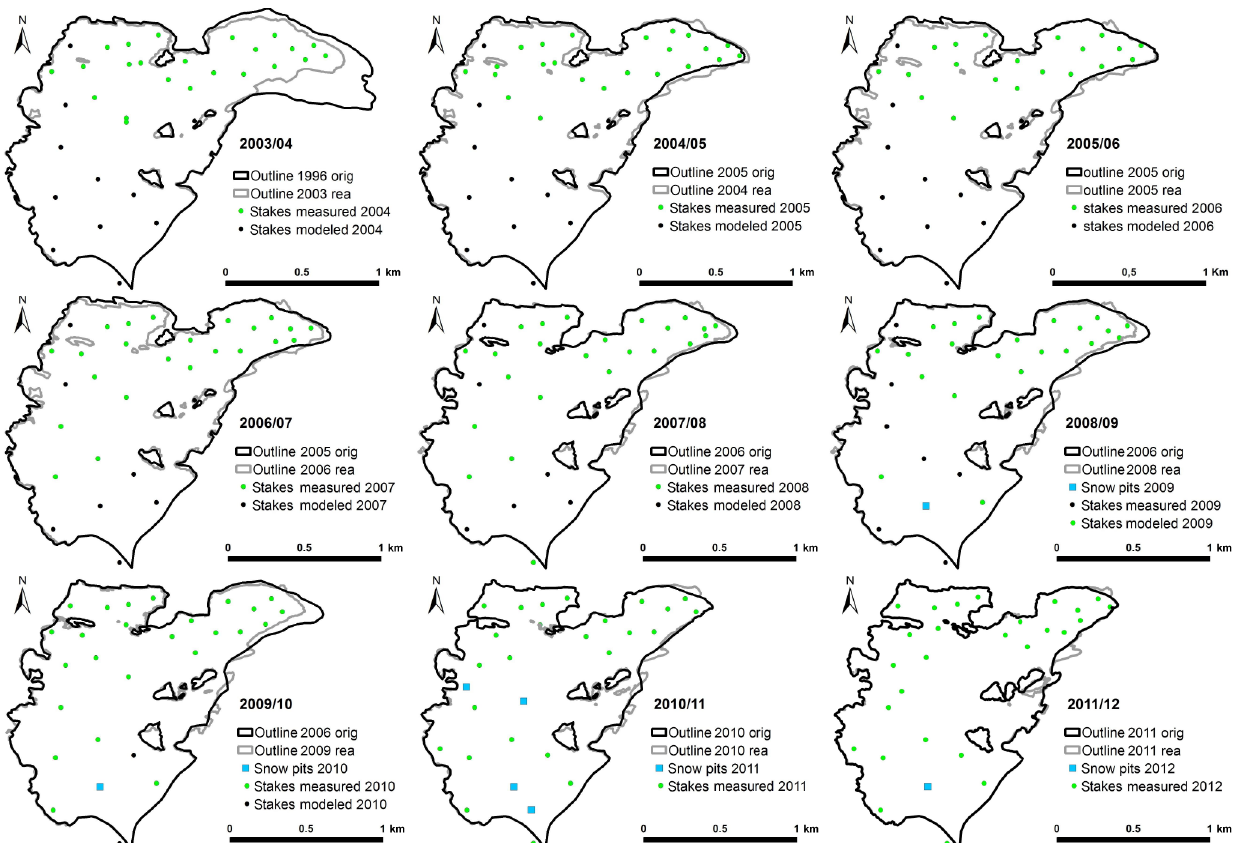
Figure 2. Measured and modeled point balances as used for the calculation of annual balance at Langenferner. Black glacier outlines are those used in the original analyses while gray lines refer to the reanalyzed outlines used in this study. Green and blue symbols indicate direct measurements which were used in the original analyses and after homogenization also in this study. Black dots symbolize modeled point values generated and used in the